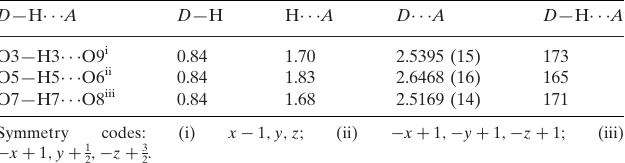
Hydrogen-bond geometry (A˚ , (cid:3)